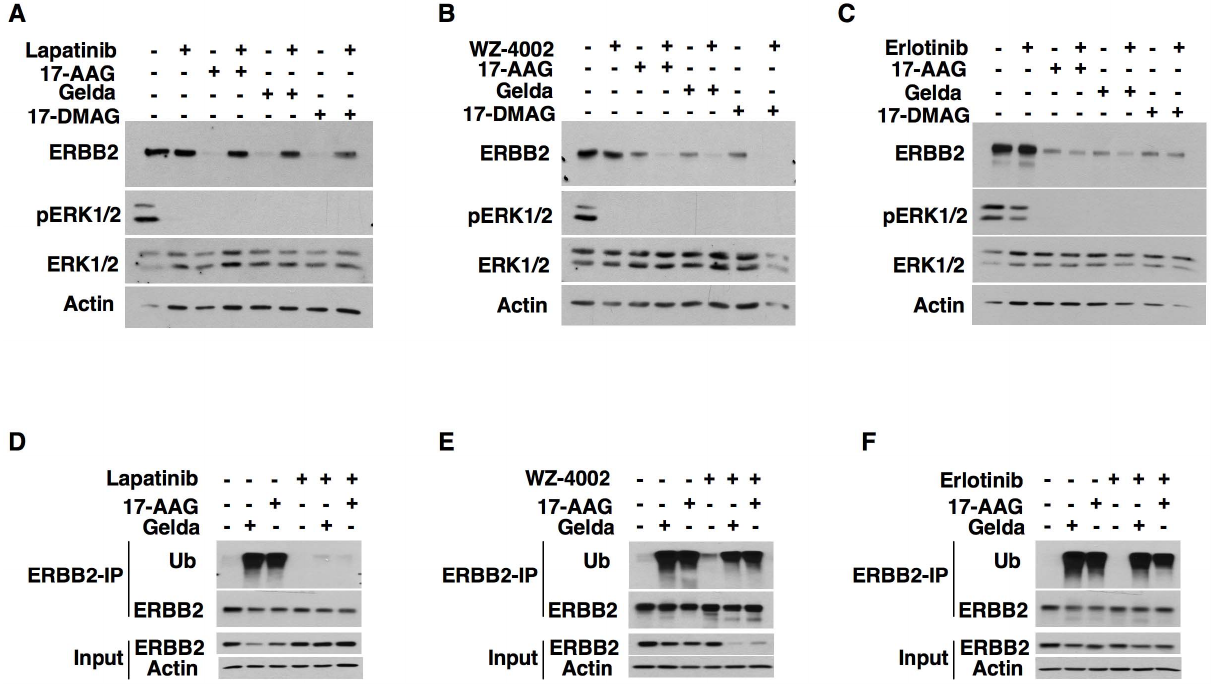
Figure 2. Blocking ERBB2 in an inactive conformation prevents HSP90 inhibitor induced ERBB2 degradation. (A–C) Ba/F3 cells stably expressing wild type ERBB2 (Ba/F3-ERBB2-WT)[9] were pre-treated with either 1 m M lapatinib (A), 1 m M WZ-4002 (B), or 1 m M erlotinib (C) for 2 hours before HSP90 inhibitor treatment (1 m M of geldanamycin, 17-AAG or 17-DMAG) for 2 hours. Cells were then lysed and western blotting was performed to analyze ERBB2 degradation. (D–F) To assess ERBB2 ubiquitination, Ba/F3-ERBB2-WT [9]cells were first treated with 1 m M of lapatinib (D), WZ-4002 (E), or erlotinib (F) for 2 hours followed by HSP90 inhibitor treatment (1 m M of geldanamycin, 17-AAG or 17-DMAG) for 1 hour. Cells were lysed and subjected to ERBB2 immunoprecipitation followed by immunoblotting with indicated